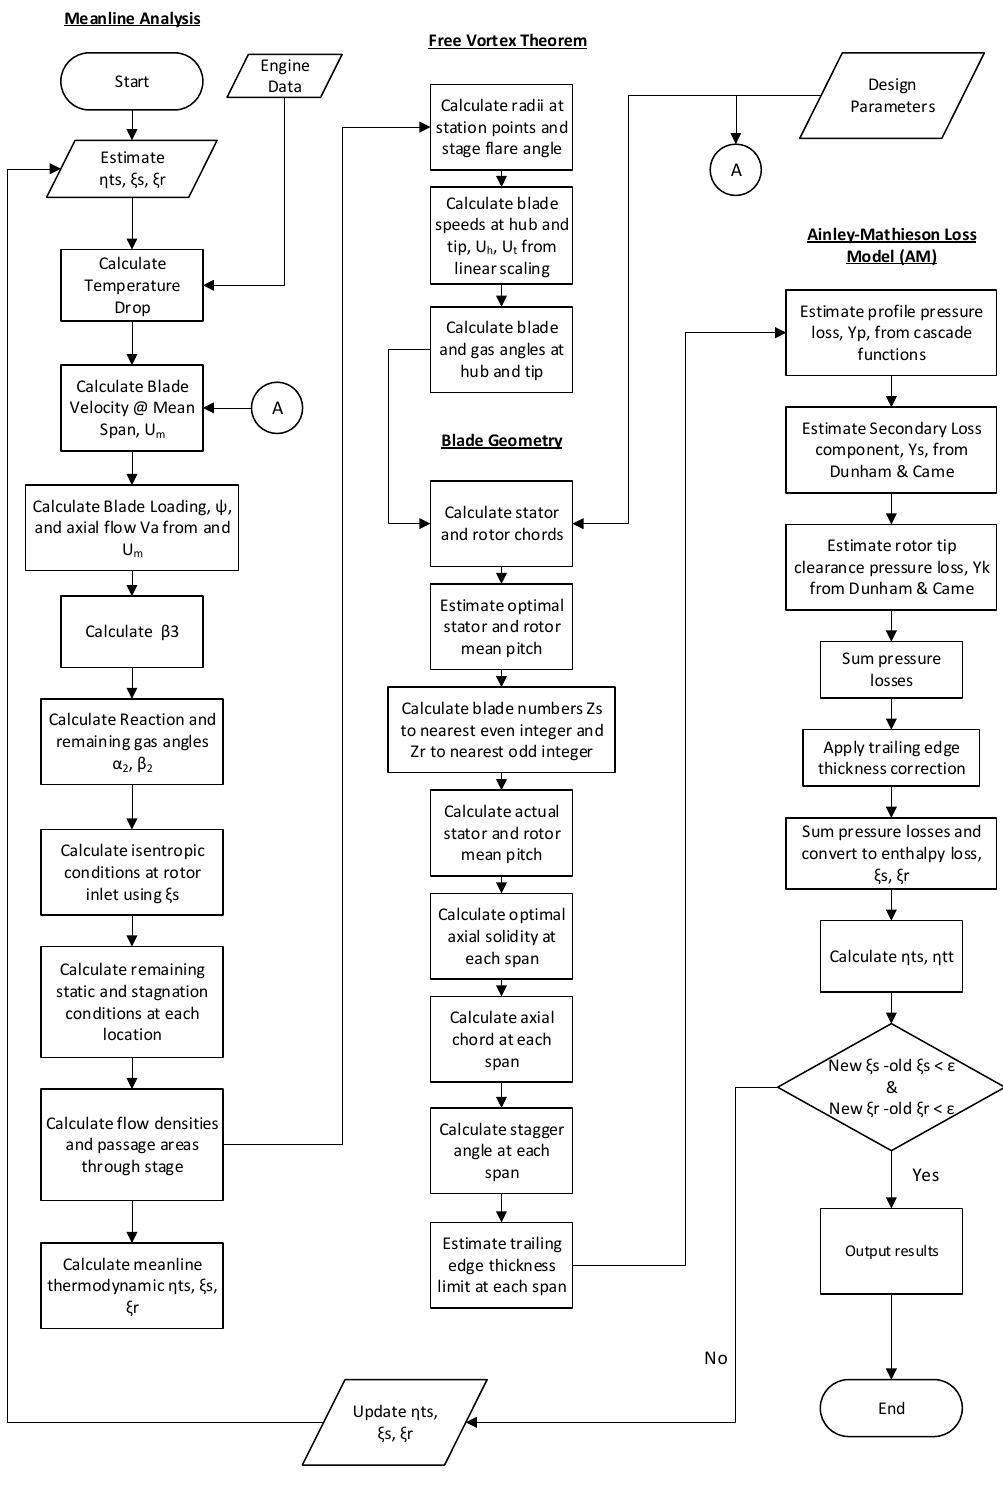
Figure 2. Flowchart of MATLAB turbine design algorithm procedure.